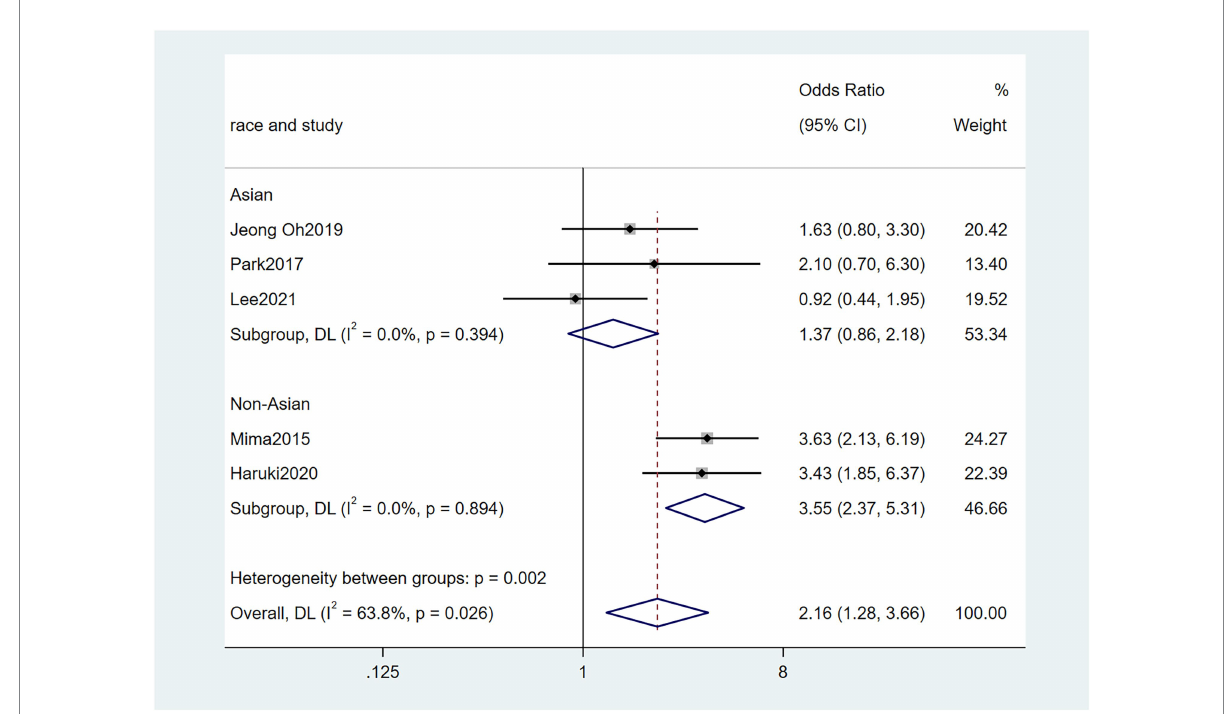
FIGURE 8 Forest plot of the relationship between Fusobacterium nucleatum and CIMP methylation in cancer.